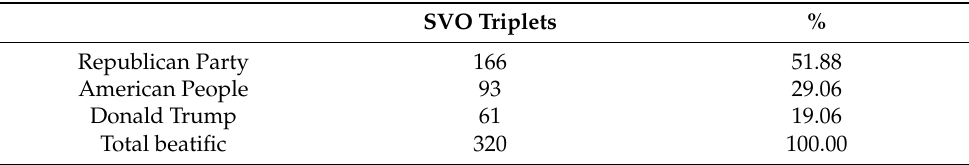
Table 8. Beatific dimension of fantasy in Trump’s Twitter